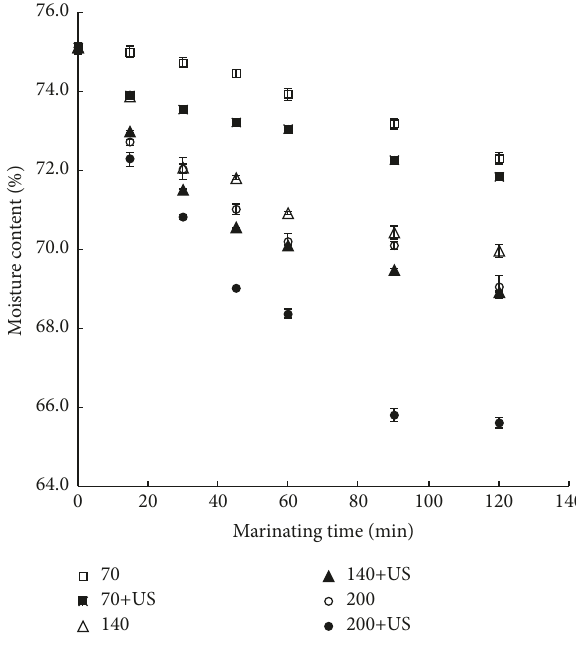
Figure 2: Moisture content in rabbit meat during marinating assisted by power ultrasound or in static bath at different salt concentrations (70, 140, and 200 g